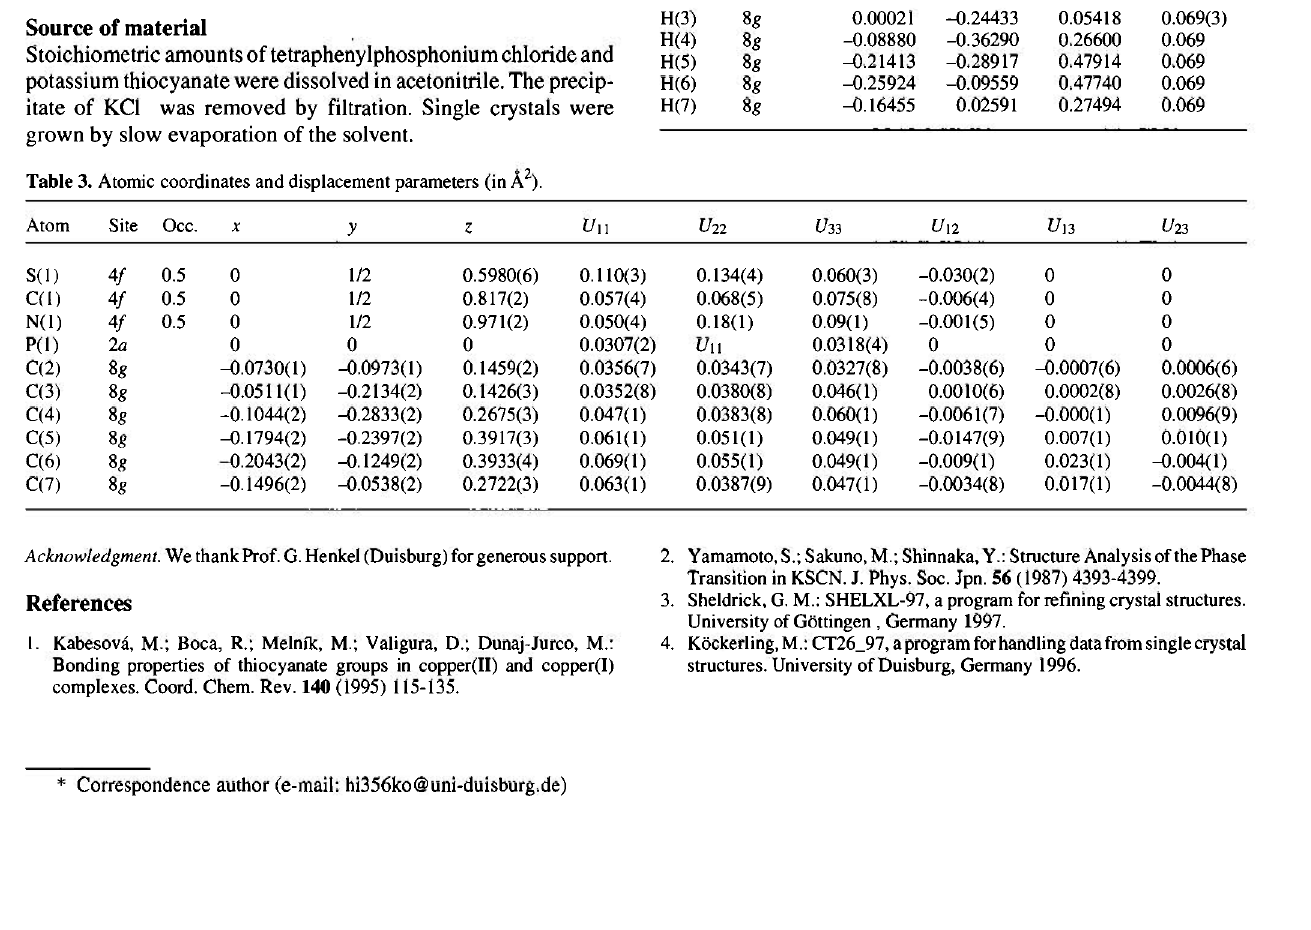
Table 2. Atomic coordinates and displacement parameters (in Ä 2